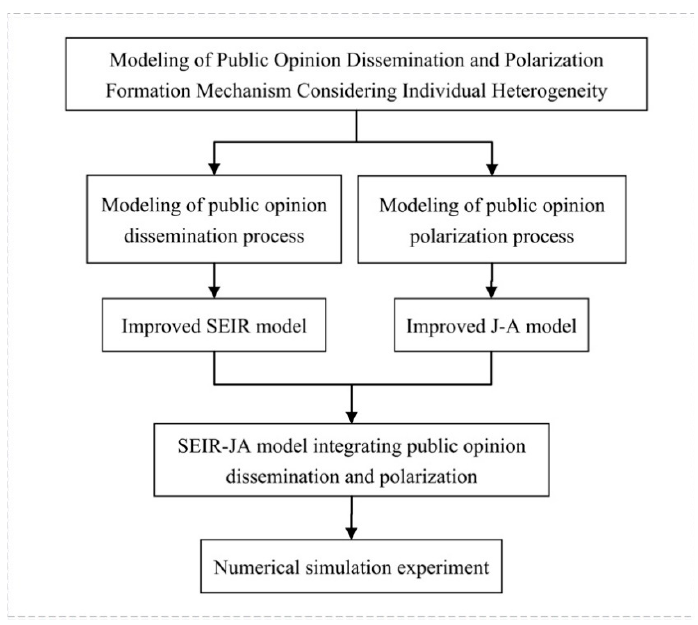
Figure 1. Research idea.